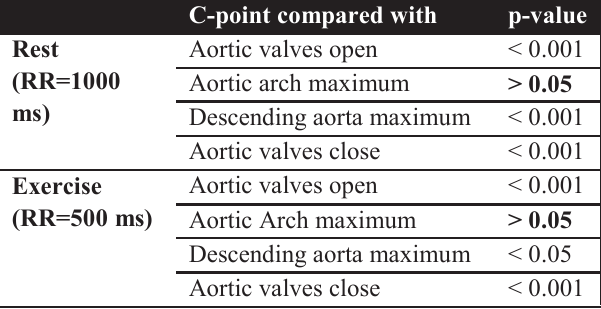
Table 2: Moment of occurrence of the C-point compared with all other heart cycle markers in all 16 subjects. Paired 2-sided t-tests were applied to the C-point and all other markers to compare the means, both in rest and after exercise. All markers differed from the moment of the C-point, except the moment of maximum diameter of the aortic arch.